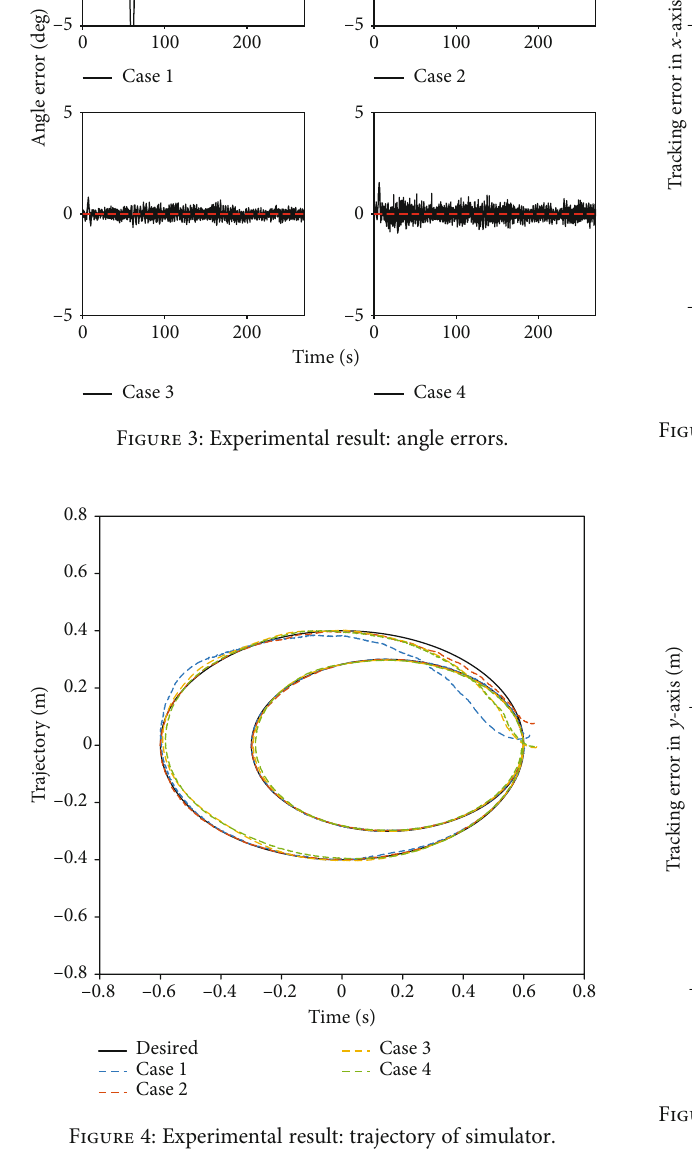
Figure 4: Experimental result: trajectory of simulator.